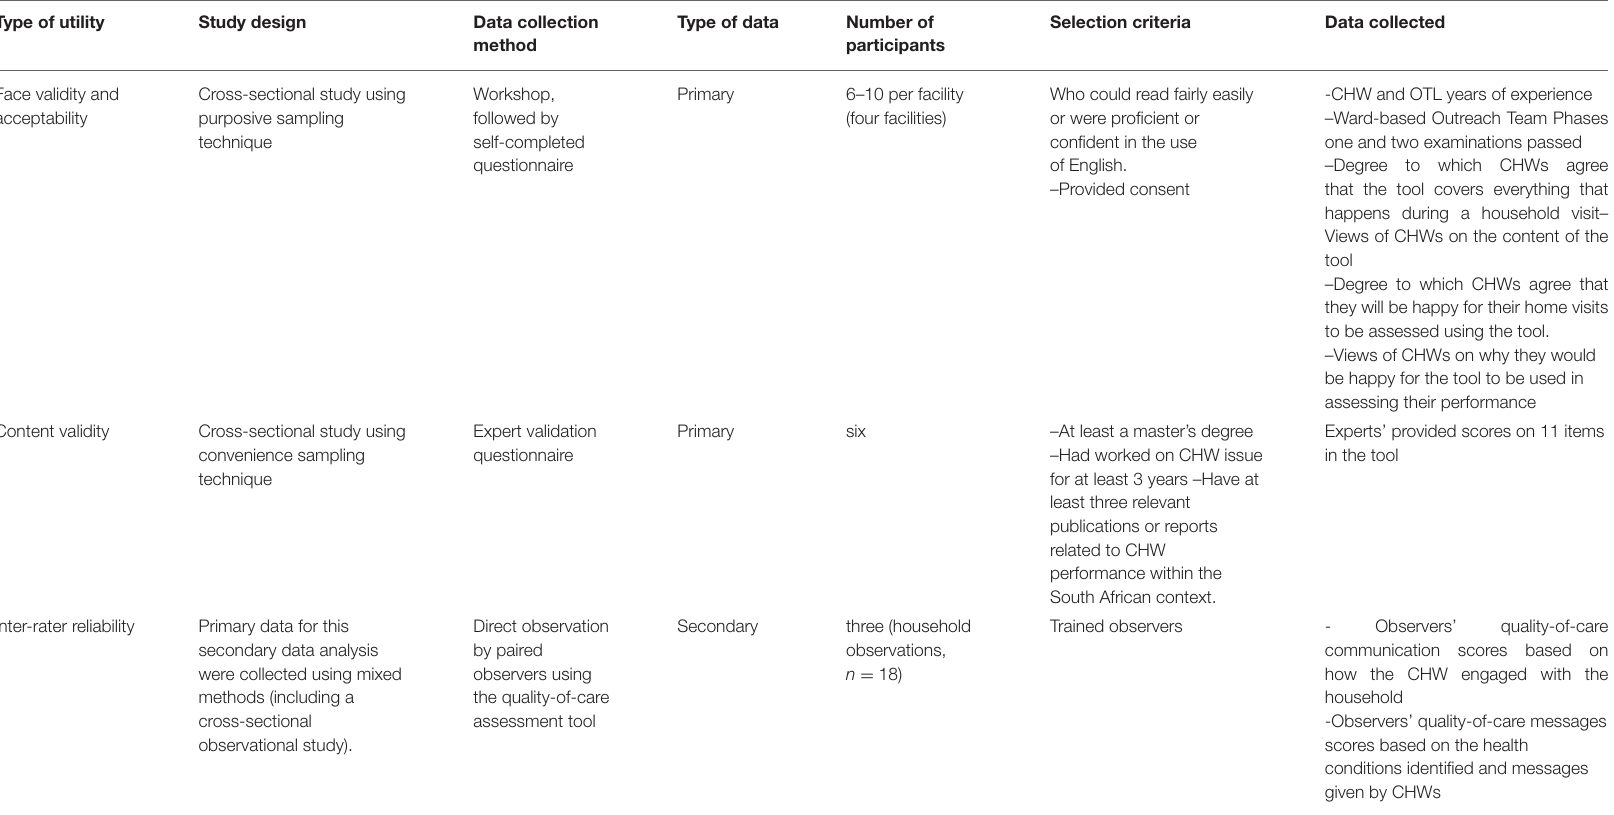
TABLE 2 | Type of utility, study design, data collection method, participants and data